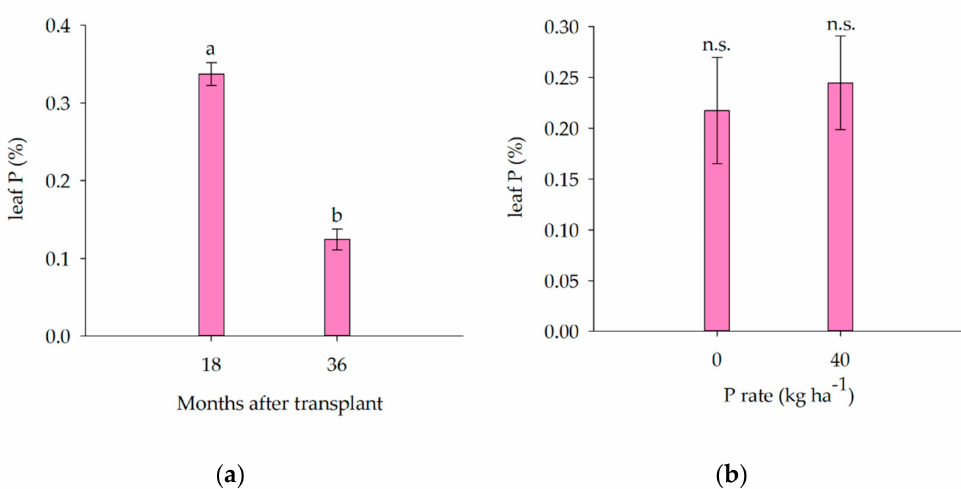
Figure 3. P concentration in leaves ( a , b ) of H. heptaphyllus plants (at 18 and 36 MAT) subjected to applications of 0 and 40 kg P ha − 1 . ( a ) depicts the adjusted bars with mean values at 18 and 36 months after transplant (MAT) compared based on Tukey’s test ( p < 0.05) without considering the P rate, since the interaction was not significant at 5% based on two-way analysis of variance. ( b ) depicts the adjusted bars with mean values of the P rate without considering time since the interaction was not significant in alpha 5% based on two-way analysis of variance. Vertical bars represent the standard error of three repetitions. n.s. = F not significant at 5% probability.